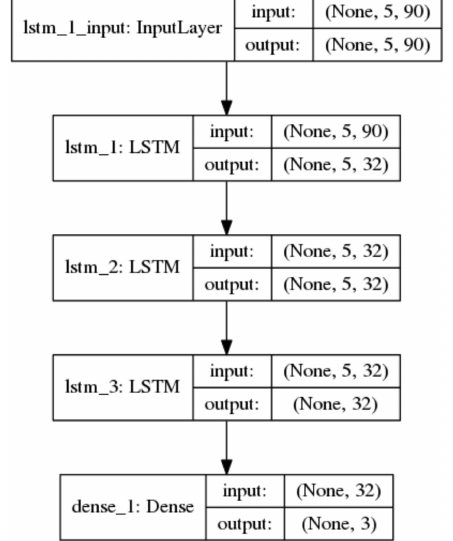
Figure 4. Proposed Topology of the LSTM Model.